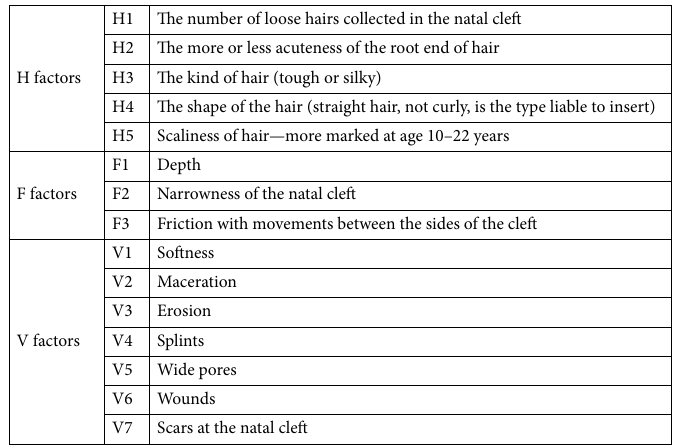
Table 1. Secondary factors in pilonidal sinus disease as defined by Karydakis in 1992 4 (reproduced with